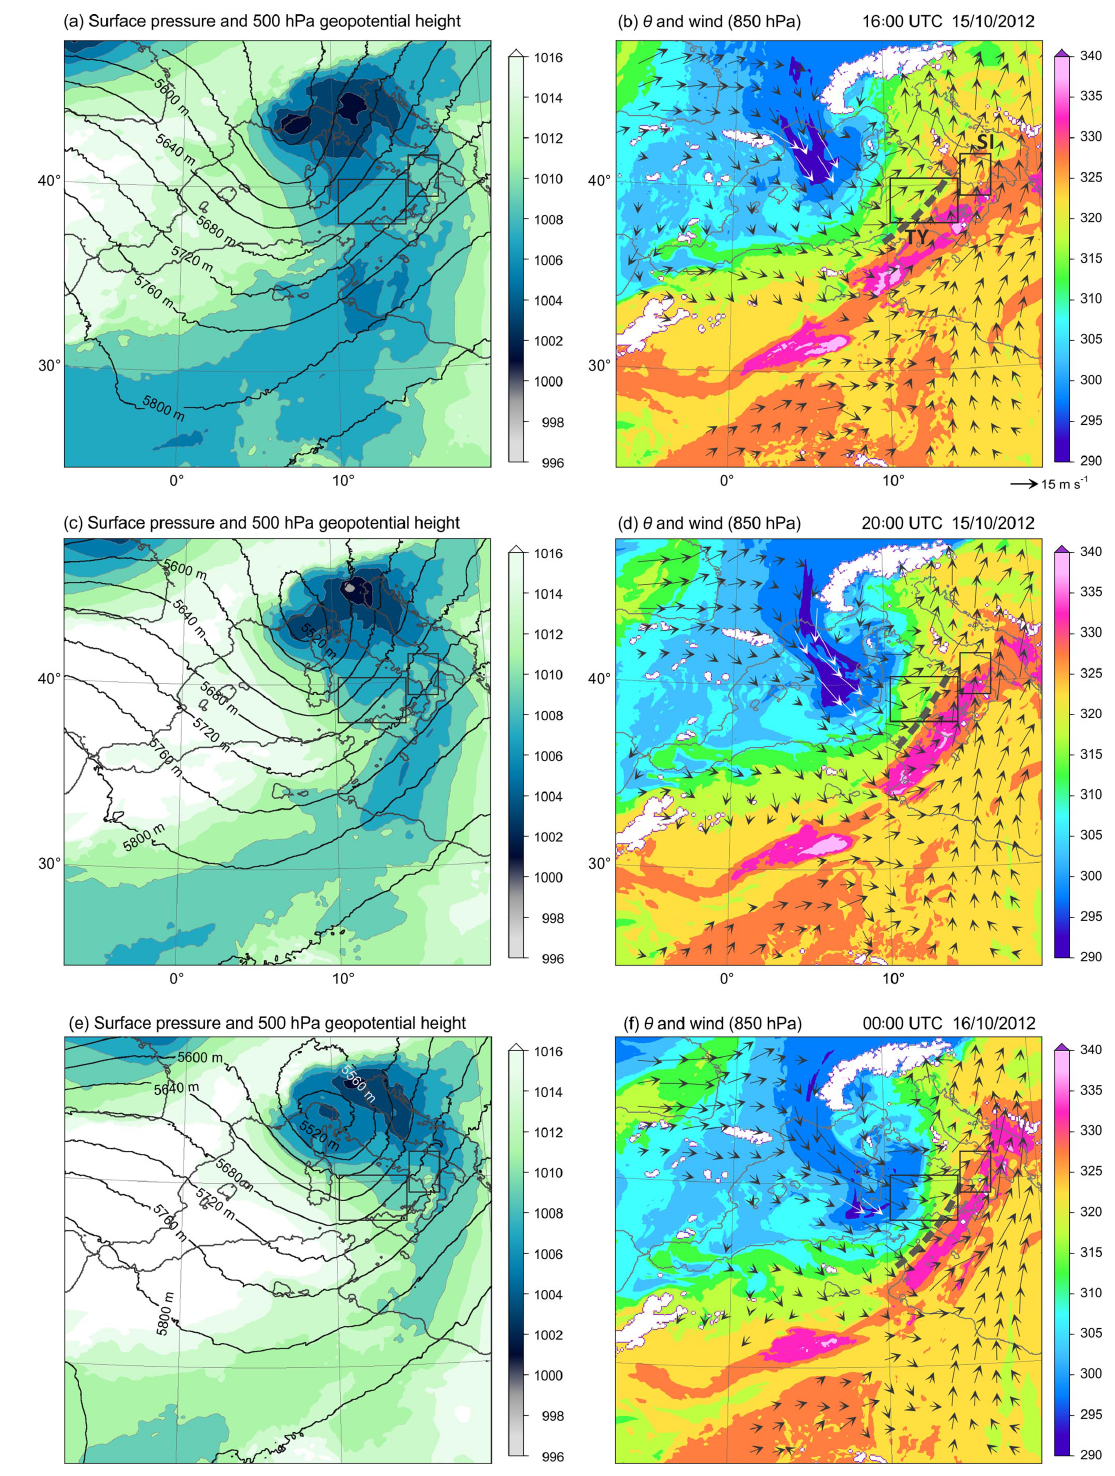
Figure 3. Horizontal distributions of sea-level pressure (shades) and geopotential height at 500hPa (contour) (a, c, e) and potential tempera- ture, θ (shades), and wind (black and white arrows) at 850hPa (b, d, f) at 16:00UTC (a, b) and at 20:00UTC (c, d) on 15 October 2012 and at 00:00UTC on 16 October 2012 (e, f) produced by the COSMOiso simulation. The coastline is depicted by the black line. The location of the cold front is depicted by a dashed line in panels (b, d, and f)